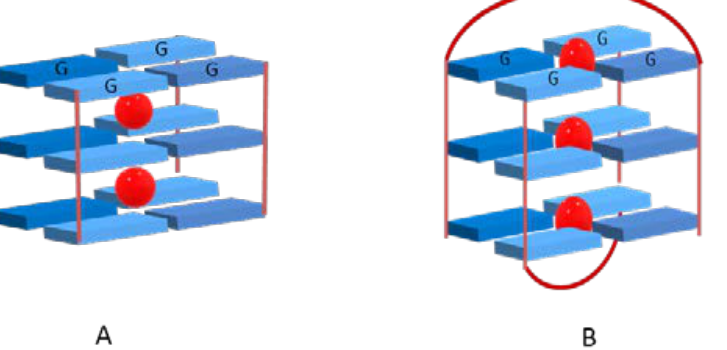
Figure 3. Cation positions between stacked quartets ( A ) or within the plane ( B ) in a G-quadruplex containing three quartets (for simplicity, backbones were omitted).